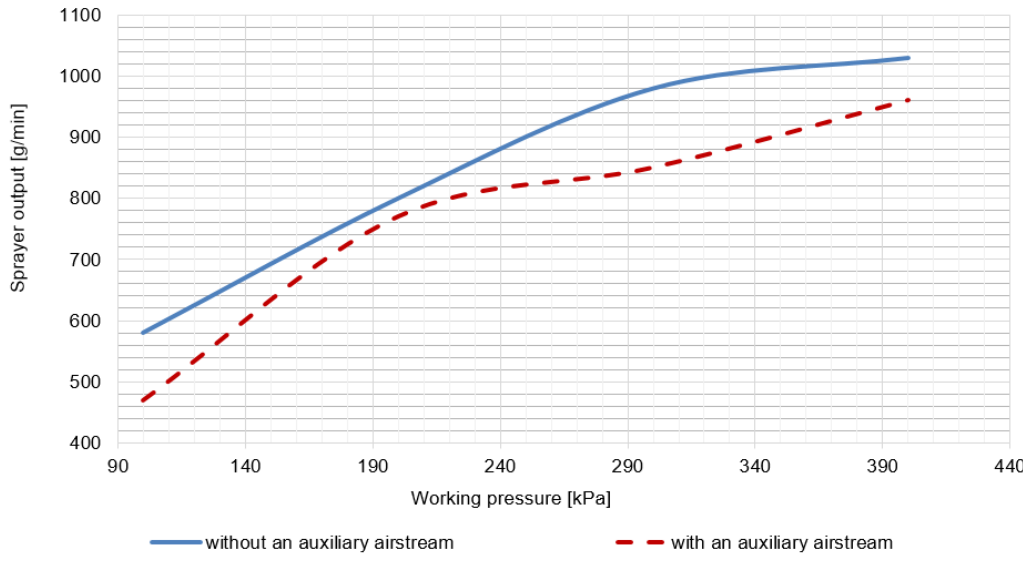
Figure 12. A comparison of the output of the working fluid flowing from the rotary sprayer without an auxiliary airstream (blue line) and from the one with an auxiliary airstream (red dashed line).